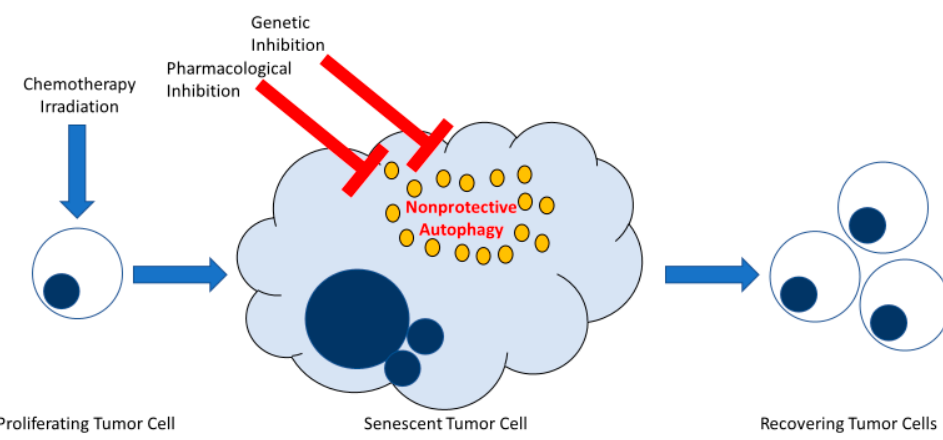
Figure 6. Early inhibition of non-protective autophagy does not interfere with recovery from therapy-induced senescence in tumor cells. Both senescence and autophagy are stress responses frequently induced in parallel in tumor cells exposed to DNA-damaging therapy. Therapy-induced senescence engenders a phase of stable growth arrest whereby a subpopulation of tumor cells can ultimately recover proliferative capacity. Autophagy induced in tumor cells in response to conventional chemotherapy or radiation takes on di ff erent functional outcomes. Of those, autophagy can be non-protective, meaning that when autophagy is blocked by pharmacological or genetic approaches, survival of tumor cells is not essentially a ff ected. This figure illustrates how the inhibition of non-protective autophagy in therapy-induced senescent tumor cells does not interfere with tumor cell survival or the ability of these cells to recover from